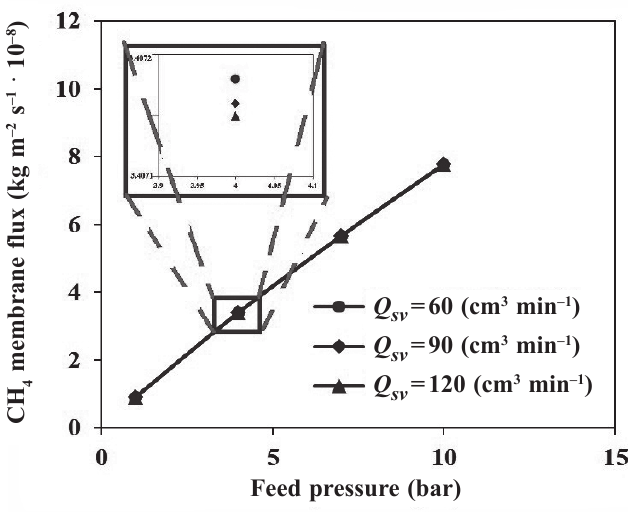
membrane flux at a 4